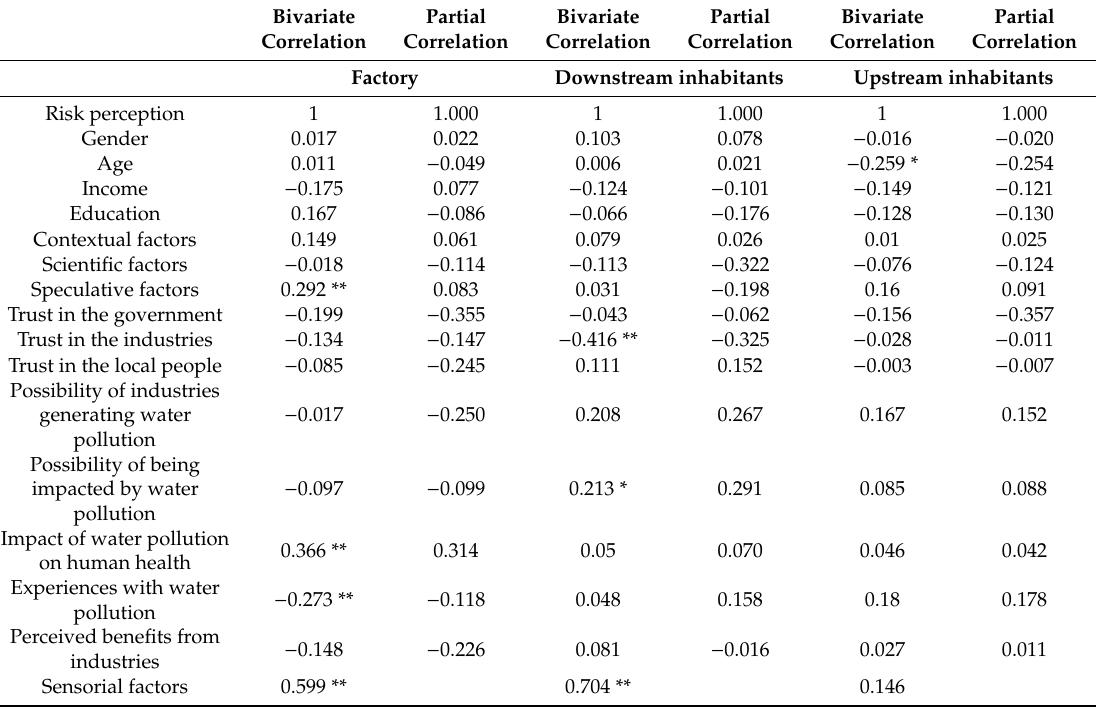
Table 6. Bivariate and partial correlations of the three groups.